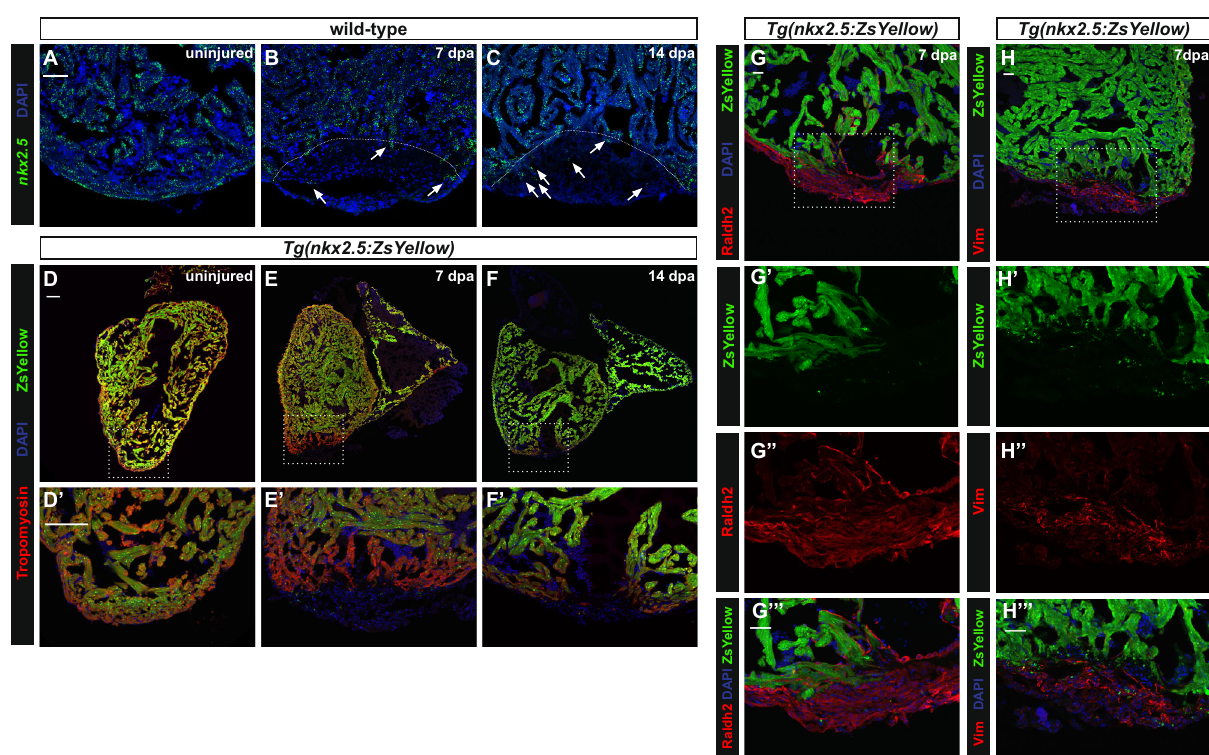
Fig. 3 Adult zebra fi sh cardiomyocytes activate nkx2.5 expression following injury. A – C Representative images of RNAscope in situ hybridization on sections of uninjured ( n = 3) ( A ) and injured wild-type hearts at 7 dpa ( n = 3) ( B ), and 14 dpa ( n = 3) ( C ) highlight nkx2.5 expression in the entire ventricle, expanding into the regenerate. Dashed lines represent amputation planes. Scale bar, 50 μ m. D – F ′ Co-localization of Tg(nkx2.5:ZsYellow) and Tropomyosin delineates nkx2.5 expression in the myocardium in both uninjured ( n = 4) ( D ) and injured wild-type hearts at 7 dpa ( n = 5) ( E ) and 14 dpa ( n = 6) ( F ). Higher magni fi cation panels ( D ′ – F ′ ) indicate the areas outlined in the rectangular boxes. Scale bar, 100 μ m. G - H ‴ ) Anti-Raldh2 ( n = 4) ( G – G ‴ ) and anti- Vimentin ( n = 5) (H – H ‴ ) immunostainings in Tg(nkx2.5:ZsYellow) fi sh highlight the myocardial-speci fi c expression of nkx2.5 . Higher magni fi cation panels ( G ′ – G ‴ , H ′ – H ‴ ) indicate the areas outlined in the rectangular boxes. Scale bar, 50 μ